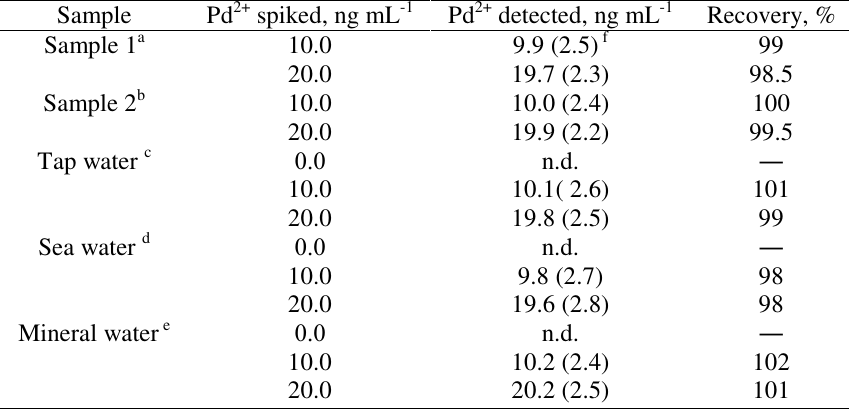
Table 2. Determination of Pd(II) in different water